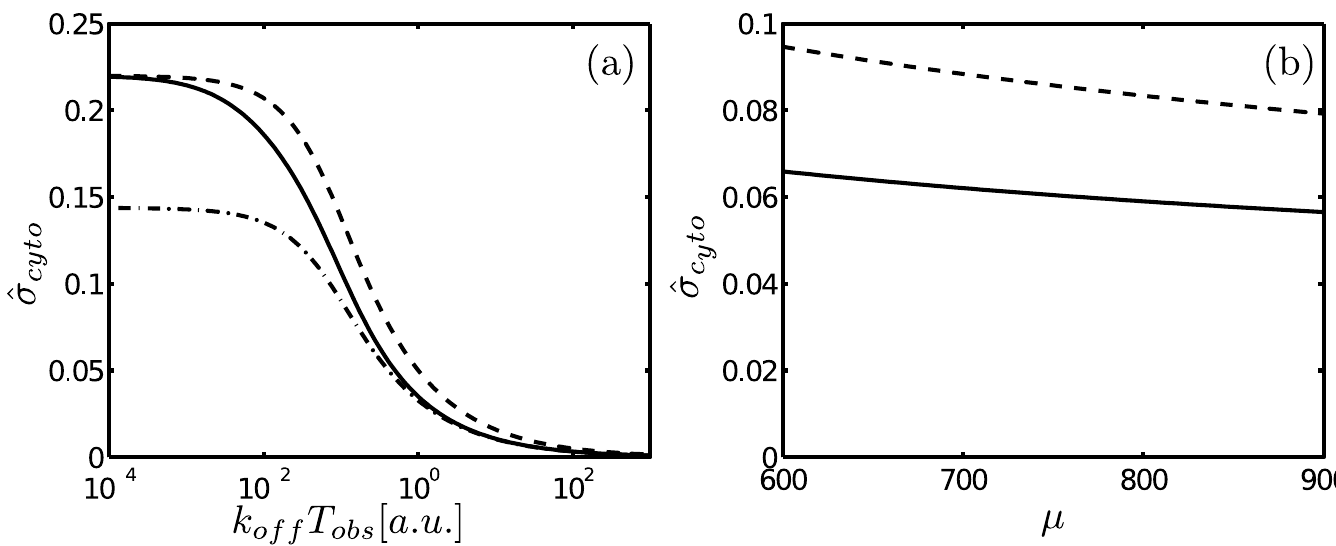
Fig 3. Comparison of different theoretical prescriptions of the fractional noise, ^ σ cyt , as time increases. (a) ^ s cyt vs T obs computed using Eq (22) with ^ s ð T ¼ 0 Þ ¼ 0 : 22 (dashed line) and with ^ s cyt obs ^ s ð T ¼ 0 Þ ¼ 0 : 22 (solid line). (b) Two of the curves displayed in (a) using the same symbols as in (a) but as functions of the mean of the accumulated cyt obs mRNA produced. The curves correspond to Eq (38) (dashed) and Eq (42) (solid) with ^ s nuc ¼ 0 : 22 in both cases.